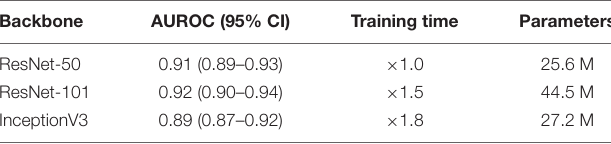
TABLE 5 | Performance of different